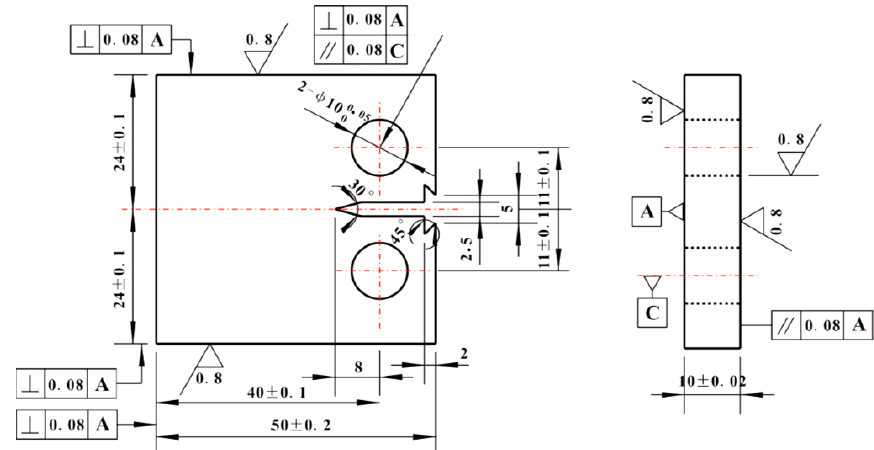
Figure 1. Size of specimen in the tensile test.